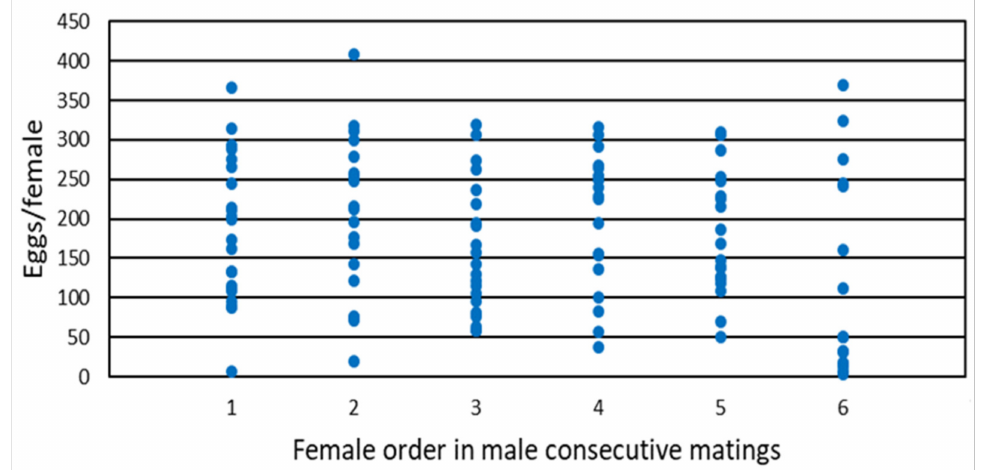
Figure 1. Lifetime fecundity of individual females of Orius laevigatus mated in sequential order by a male.